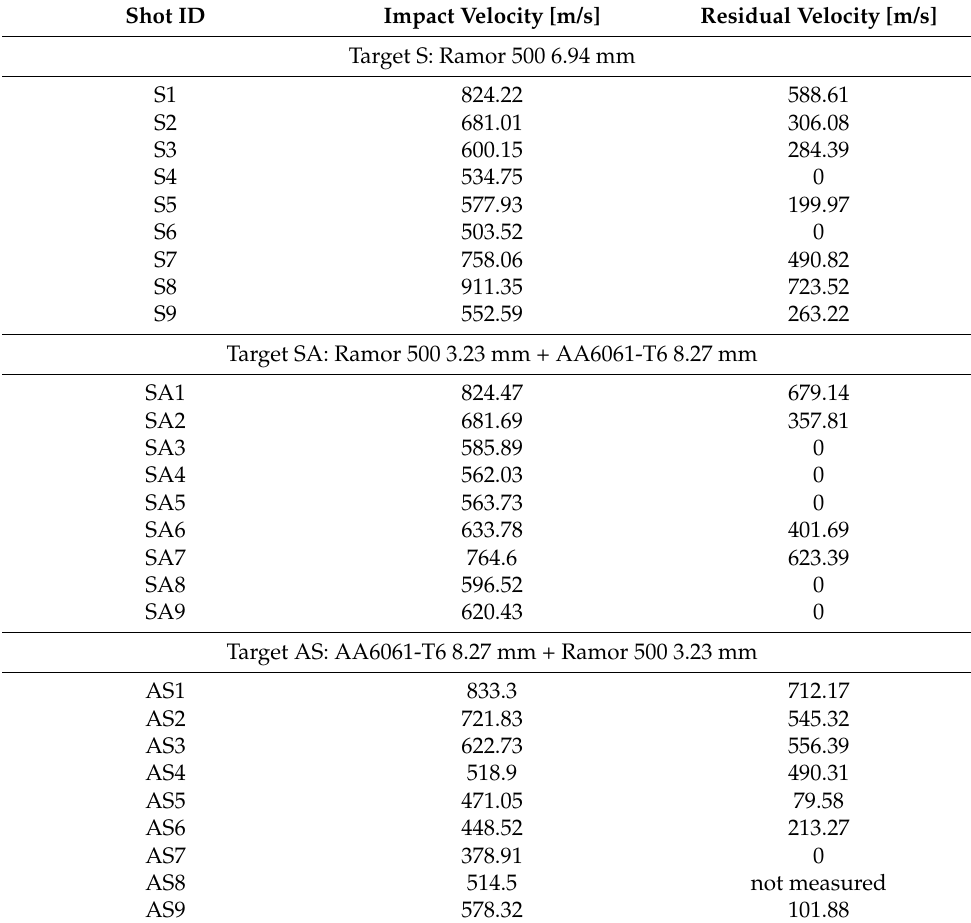
Table 3. Experimentally measured impact and residual velocity for targets S, SA and